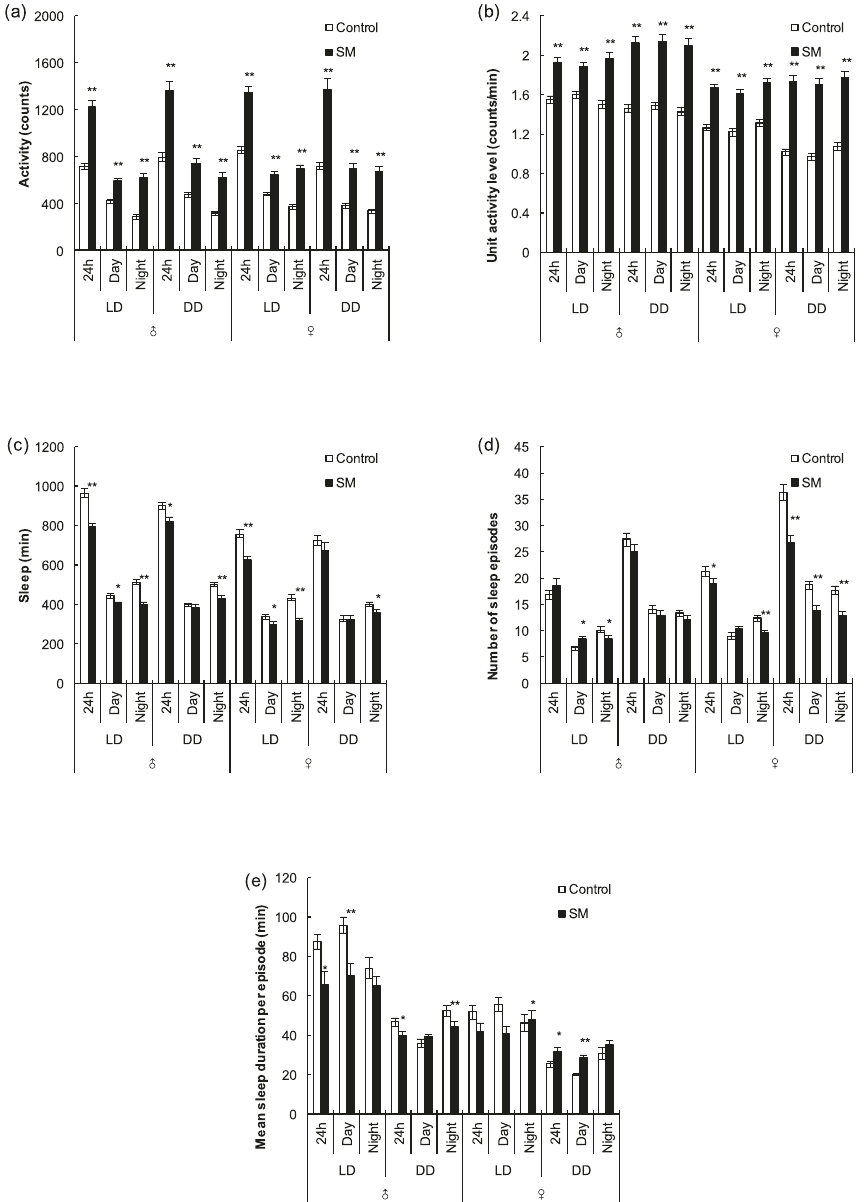
Fig. 3 Activity and sleep of w1118 male and female fruit fl ies under simulated microgravity under LD and DD conditions. a Total activity. b Unit activity level. c Total sleep time. d Number of sleep episodes. e Mean sleep duration per episode. Data were calculated by mean of 3 days. White and black boxes represent data for the control and simulated microgravity fruit fl ies, respectively. n ≥ 90. * P < 0.05, ** P < 0.01. Error bars represent standard